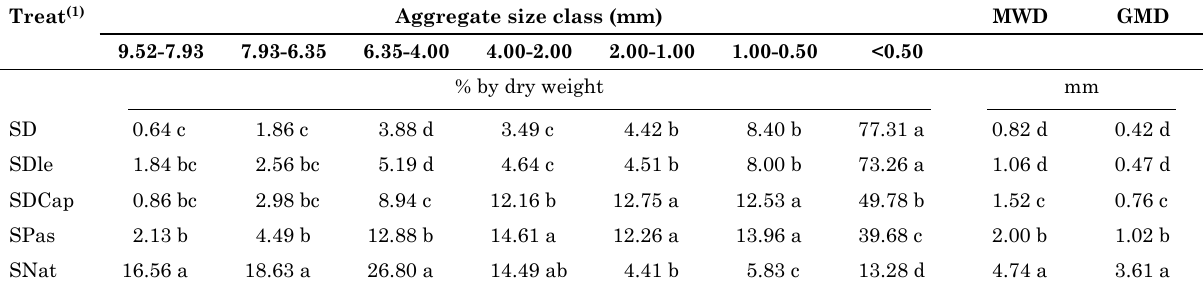
table 4. Mean values for the percentages by weight for different size classes of aggregates stable in water, and for the mean weight diameter (MwD) and geometric mean diameter (gMD) of the water-stable aggregates. Determinations were performed in 2004, for soil samples from the 0.00-0.20 m depth range, collected from five treatments in areas located around the Ilha Solteira Hydroelectric Plant, SP, Brazil treat (1)